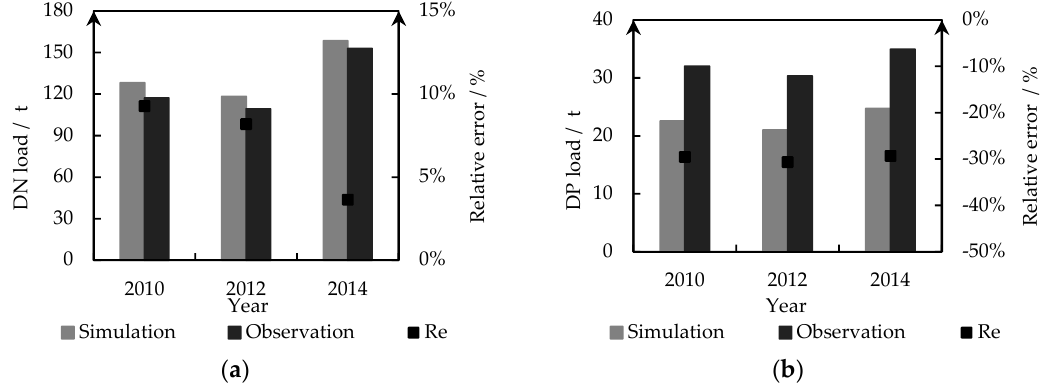
Figure 5. Comparison of simulated and measured values for ( a ) DN and ( b ) DP in the Chenghai Lake watershed.